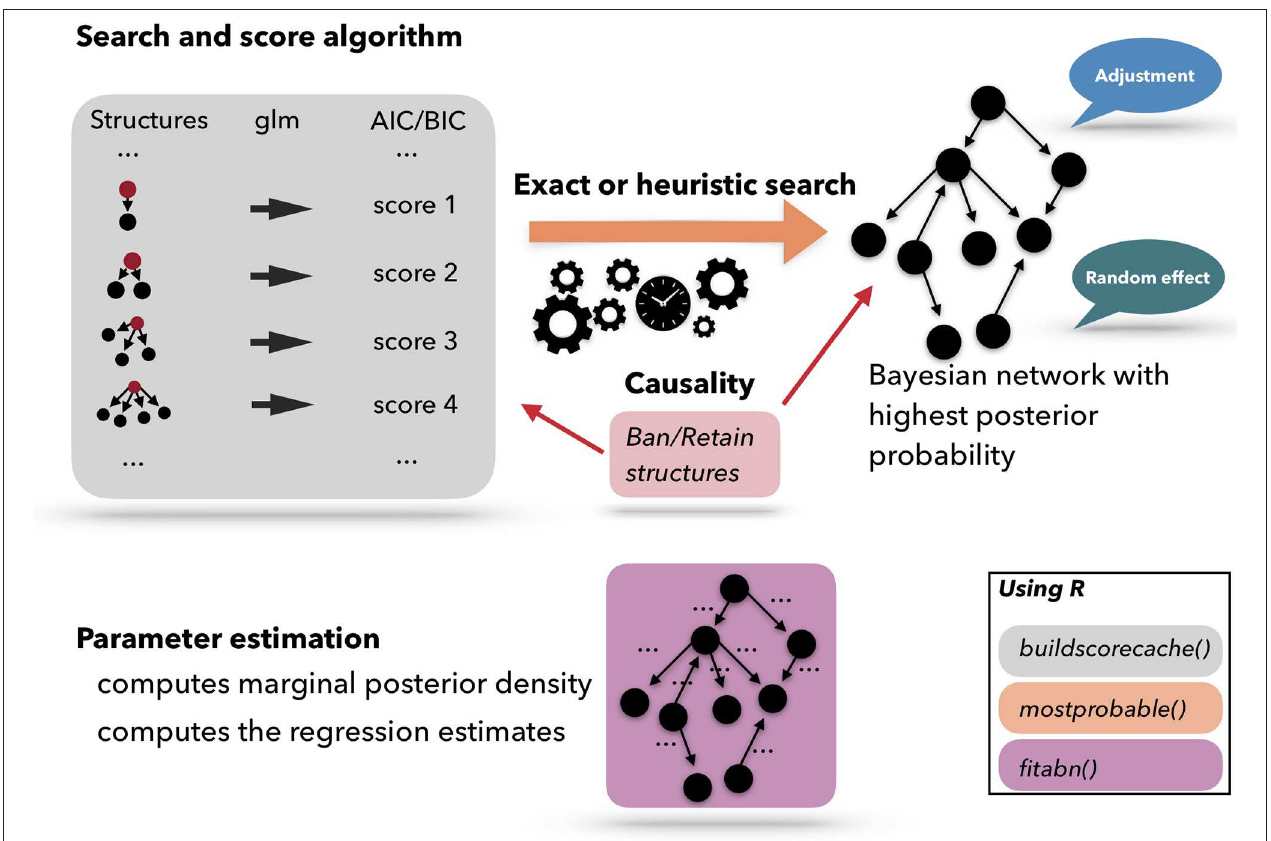
FIGURE 4 | Schematic representation of the Additive Bayesian Network workflow. First, a cache of scores is computed for atomic networks. Then, a search algorithm is used to optimize the comprehensive network. Based on the optimized network, the model parameters are learned. Those three steps are programmed in three different R functions: buildscorecache(), mostprobable(), and fitabn()